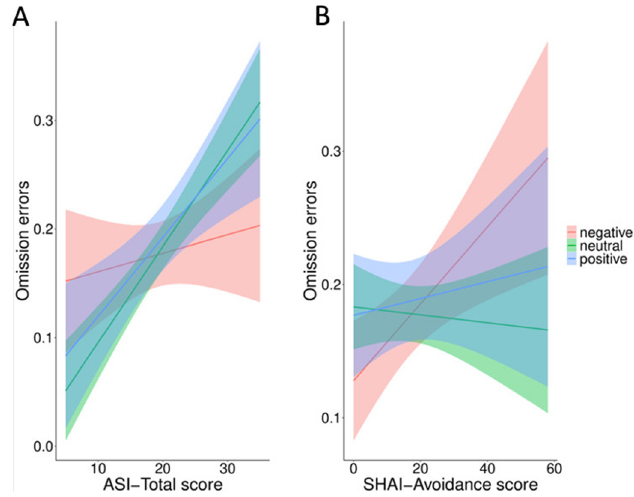
Figure 3. Omission errors for positive, negative and neutral words as function of ASI-3 total score ( A ) and SHAI- avoidance score ( B ).